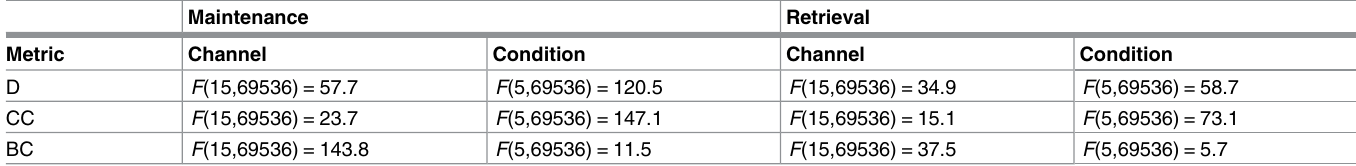
Table 2. Results from the 2-way ANOVA comparing Condition and Channels.